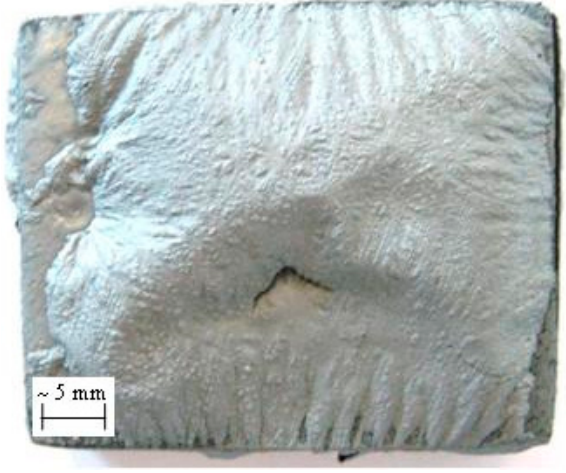
Figure 5. Surface of the sample after one hour of annealing at T a = 1100 °C and cooling in air.